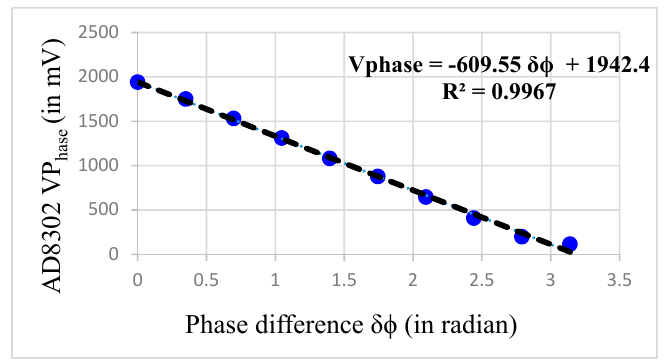
Figure 5. The change in V Phase with change in phase difference at 40 kHz.